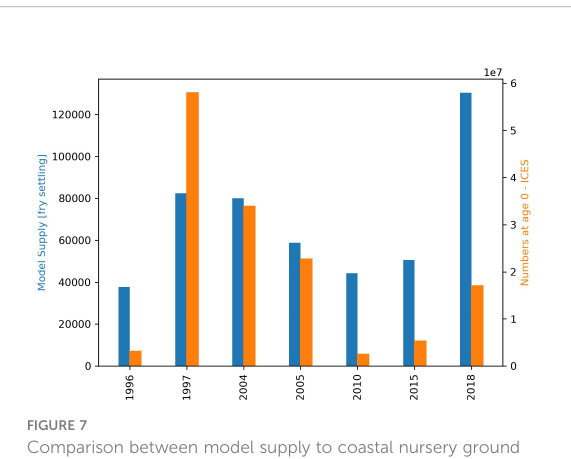
FIGURE 6 Monthly mean duration of egg and larva phases of development. Grey bars indicate the range in mean total duration (combined egg and larva) for all years of